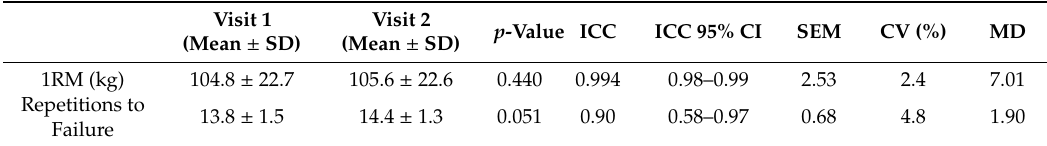
Table 2. Test-retest reliability for bench press one repetition maximum (1RM) and bench press repetitions to failure.